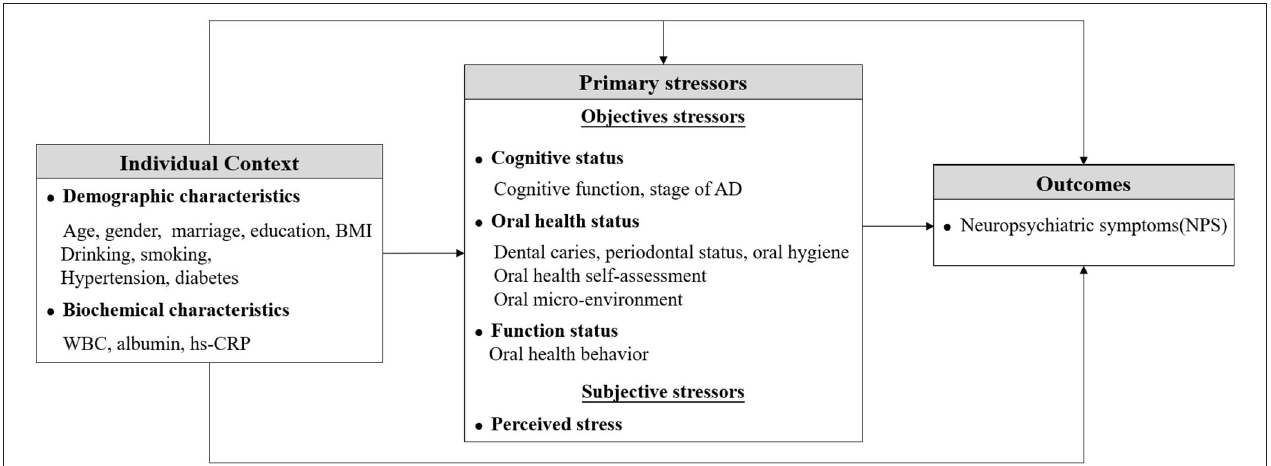
FIGURE 1 | The conceptual framework of this